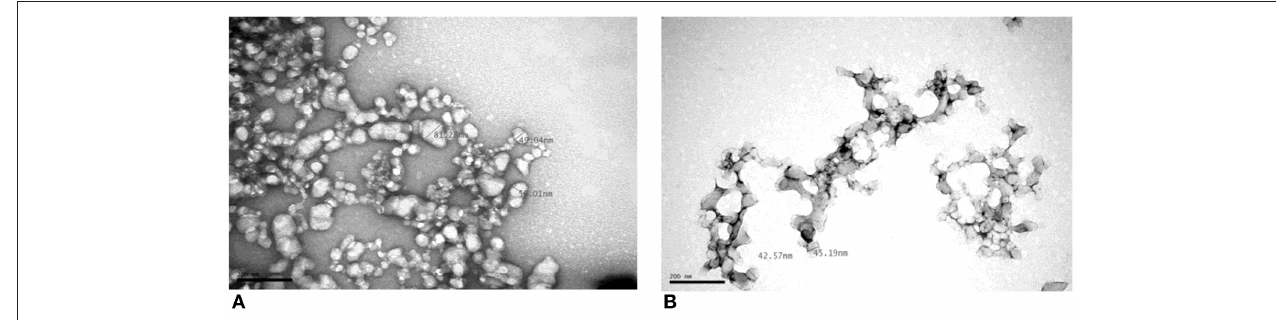
FIGURE 4 | Transmission electron microscopy (TEM) photographs of unloaded (A) and curcumin-loaded (B) micelles from GA1.